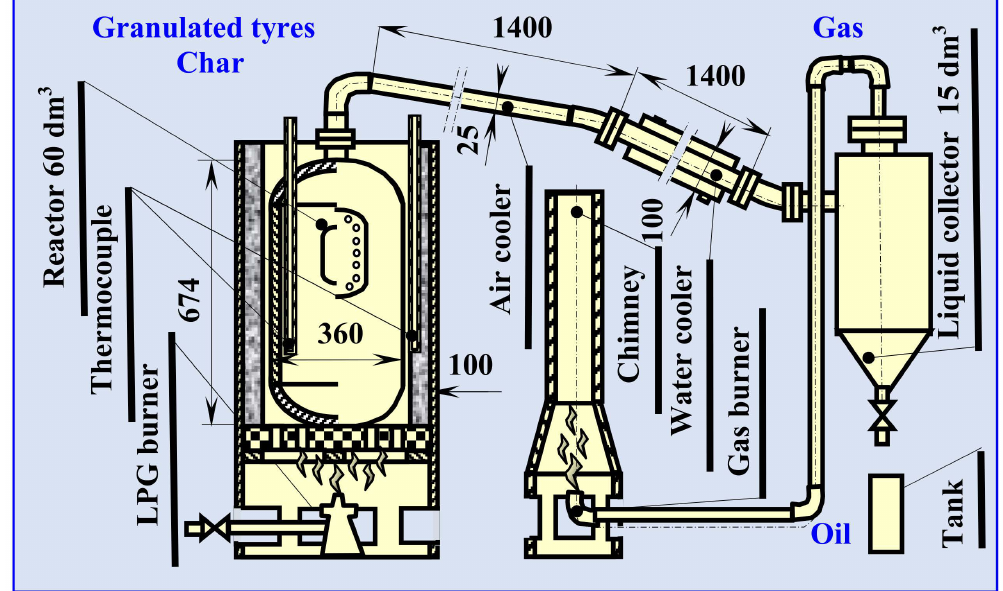
Figure 3. Scheme of the fixed bed reactor (semi-technical scale) used in this experimental study for granulated tire